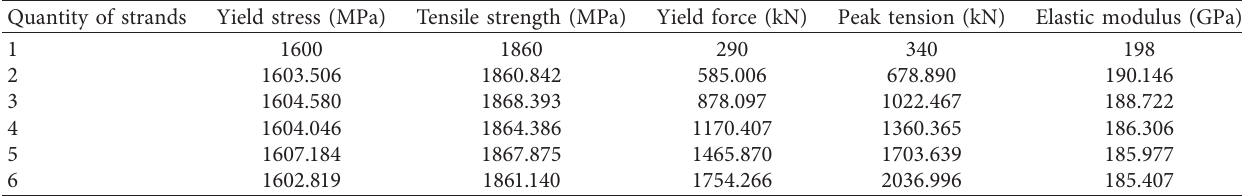
Table 2: Test results of elastic modulus of the multistrand steel